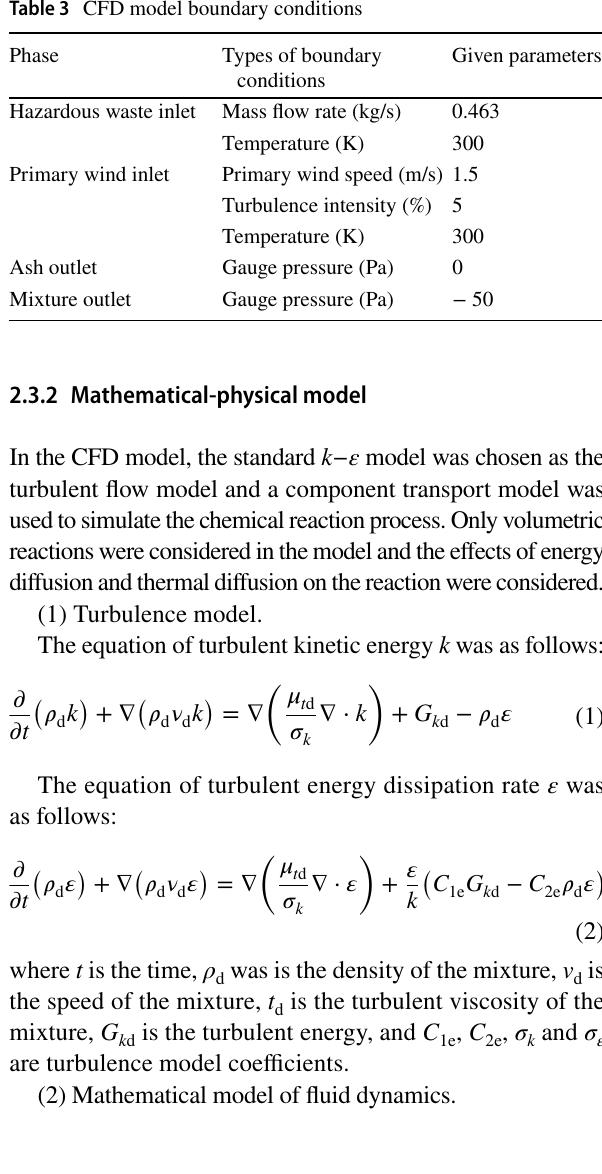
Fig. 3 Schematic diagram of the geometric of the counter-flow rotary